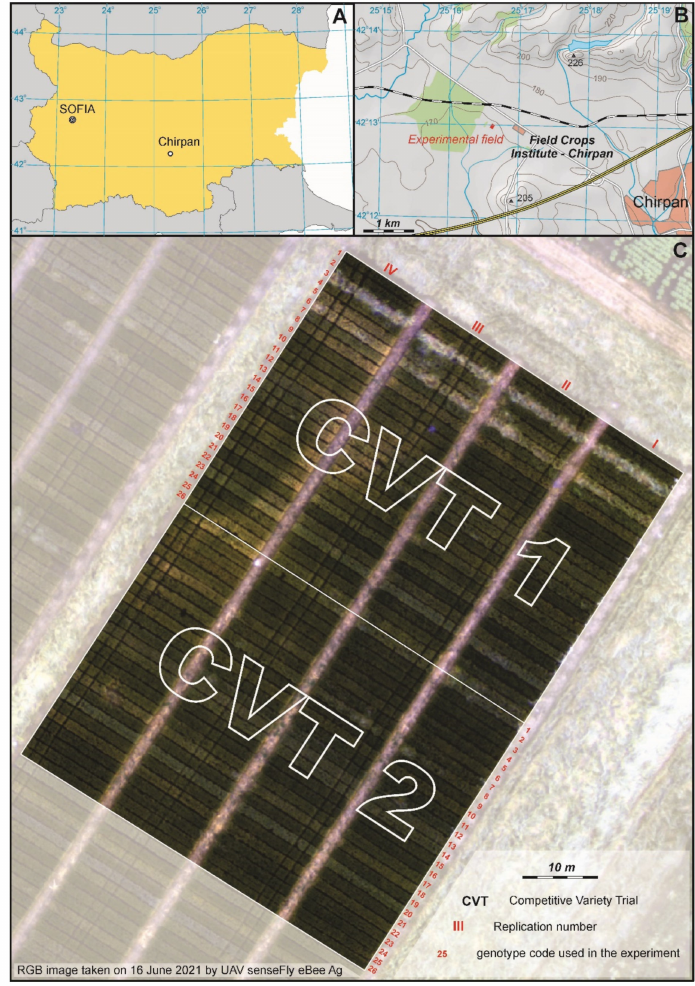
Figure 1. Study area. ( A )—Location of FCI-Chirpan in Bulgaria. ( B )—Location of the breeding experimental field. ( C )—Orthophoto map of the breeding experimental field divided into 208 plots and two competitive variety trials (CVTs); each CVT has 26 genotypes with 4